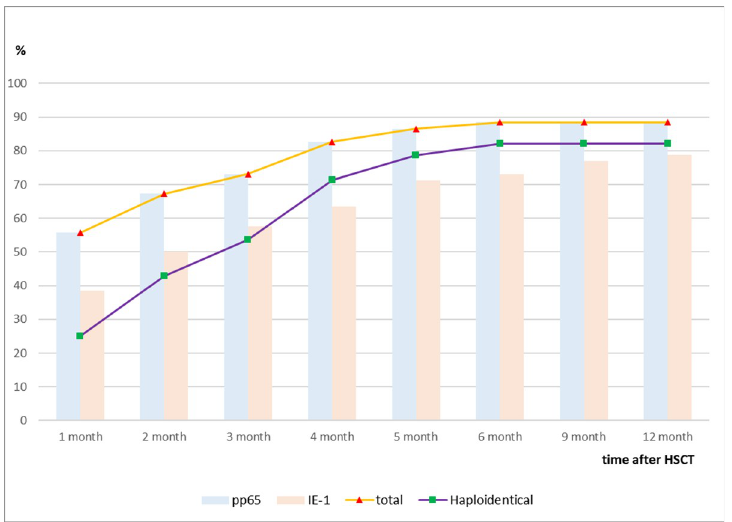
Fig 1. Cumulative rate of recovery of CMV-specific CMI over time after HSCT. CMV-specific immunity determined by pp65 antigen (blue bar) was restored earlier than that determined by IE-1 (pink bar). Compared to overall HSCT recipients (red triangle), recipients from haploidentical donors (green square) tended to recover their CMV-specific CMI later.